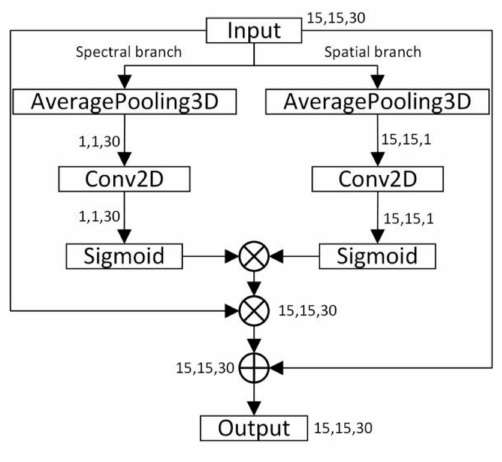
Figure 2. Flowchart of the hybrid attention mechanism.